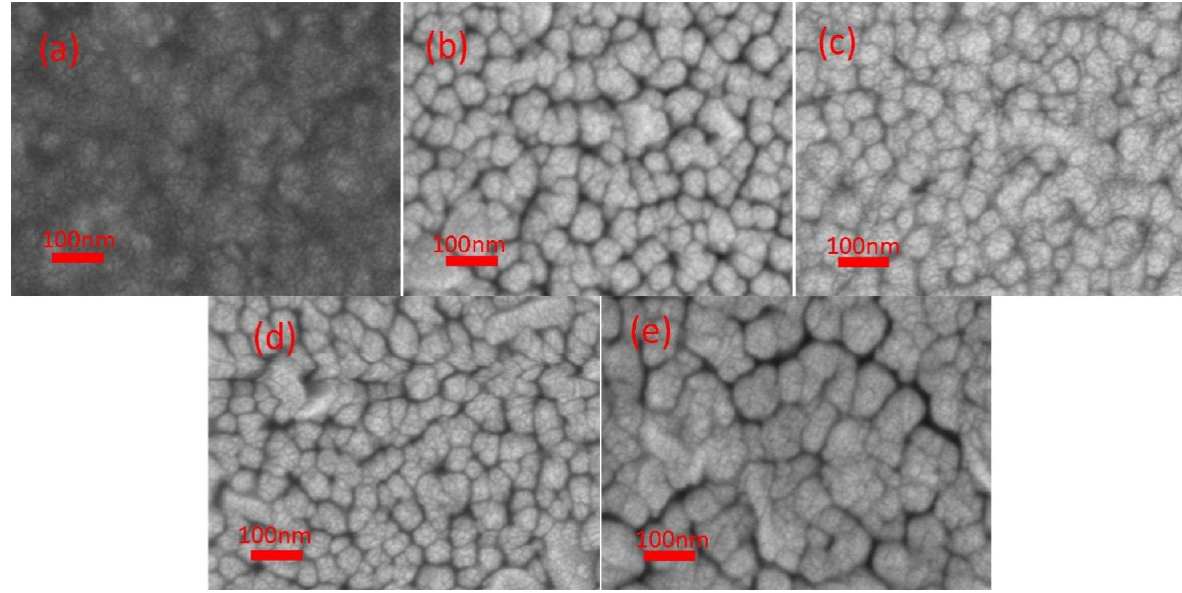
Figure 2. SEM top-view images of ZnO/TiO 2 films: ( a ) ZT1; ( b ) ZT2; ( c ) ZT3; ( d ) ZT4; ( e ) ZT5.